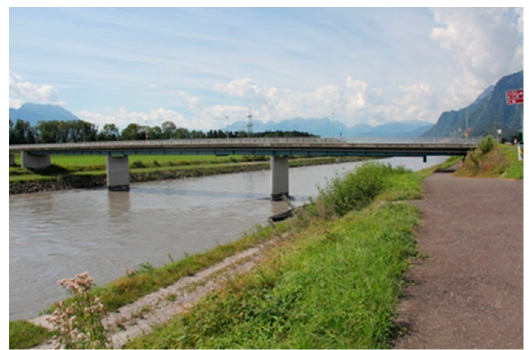
Figure 20. Bridge over the river Rhine near Oberriet in Switzerland.